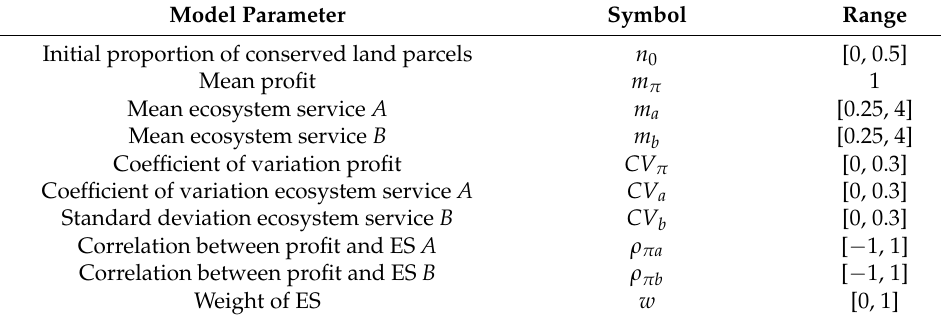
Table 2. Ranges of the model